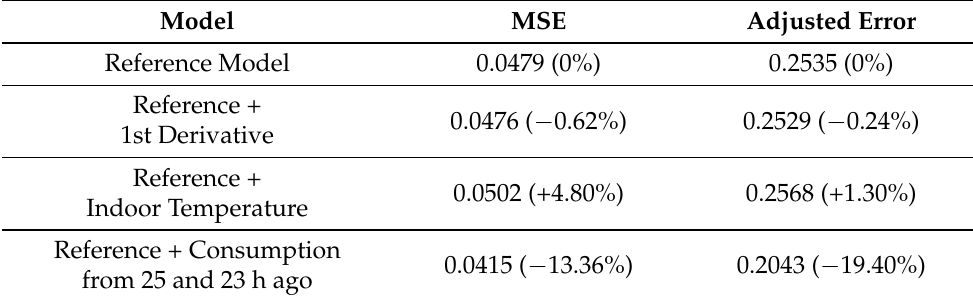
Table 3. Analysis of the addition of features on model